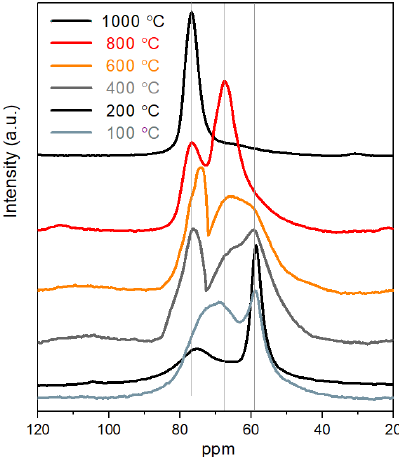
Figure 1. The 27 Al MAS NMR spectra of synthetic geopolymer vs. temperature of heat treatment. Figure 2 represents Al NMR spectra of samples with different—reduced iron and rare earth metal oxide-containing—red mud (rmr) content. The samples with original red mud content cannot be used for Al NMR investigation due to the strong ferromagnetic effect of iron oxide.